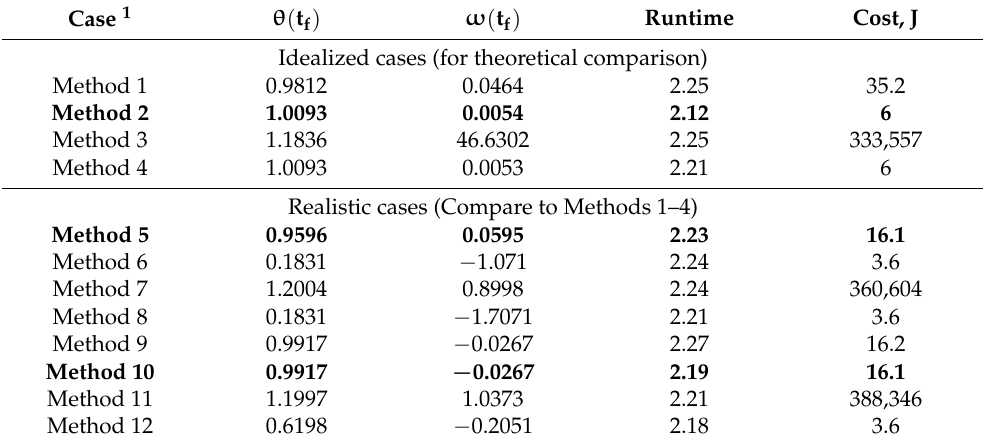
Figure 5. Simulation test results: subfigures ( a – l ) display qualitative results, while corresponding quantitative figures of merit are in Table 7 inserted into subfigure. The abscissa displays scaled time normalized to vary between zero and unity. The ordinant displays displacement and rate, respectively represented by dotted and dashed lines. Table 7. Quantitative figures of merit corresponding to the qualitative data presentation in accompanying Figure 5a–l 1 .